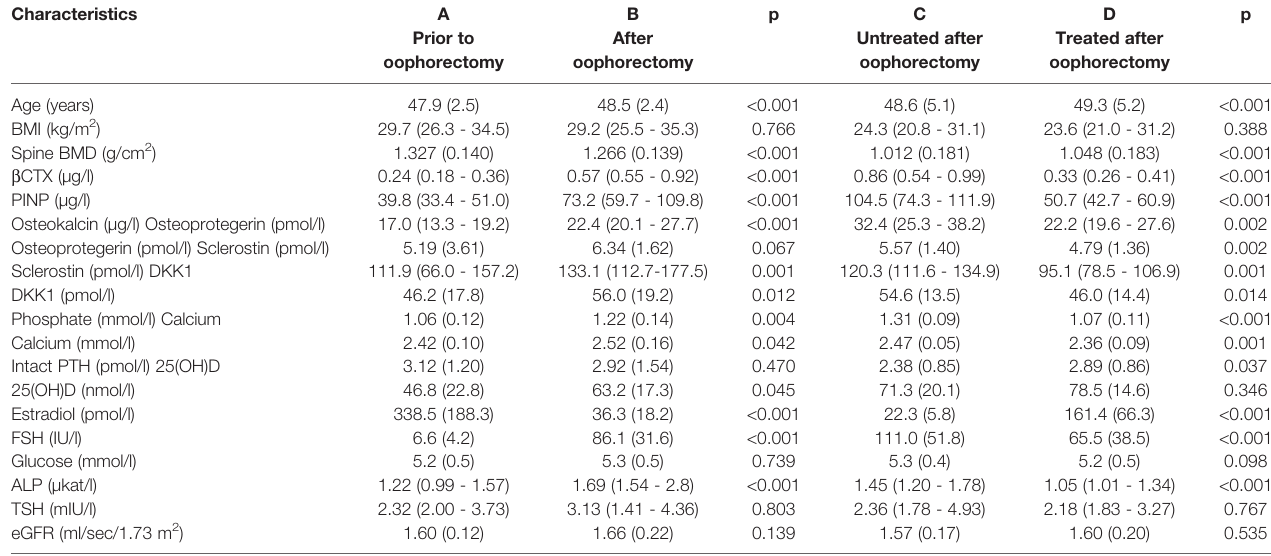
TABLE 1 | Characteristics of 11 untreated women prior to oophorectomy (A) and 201 days after oophorectomy (B) and 11 untreated women 508 days after oophorectomy (C) and then after 203 days of estradiol treatment (D).